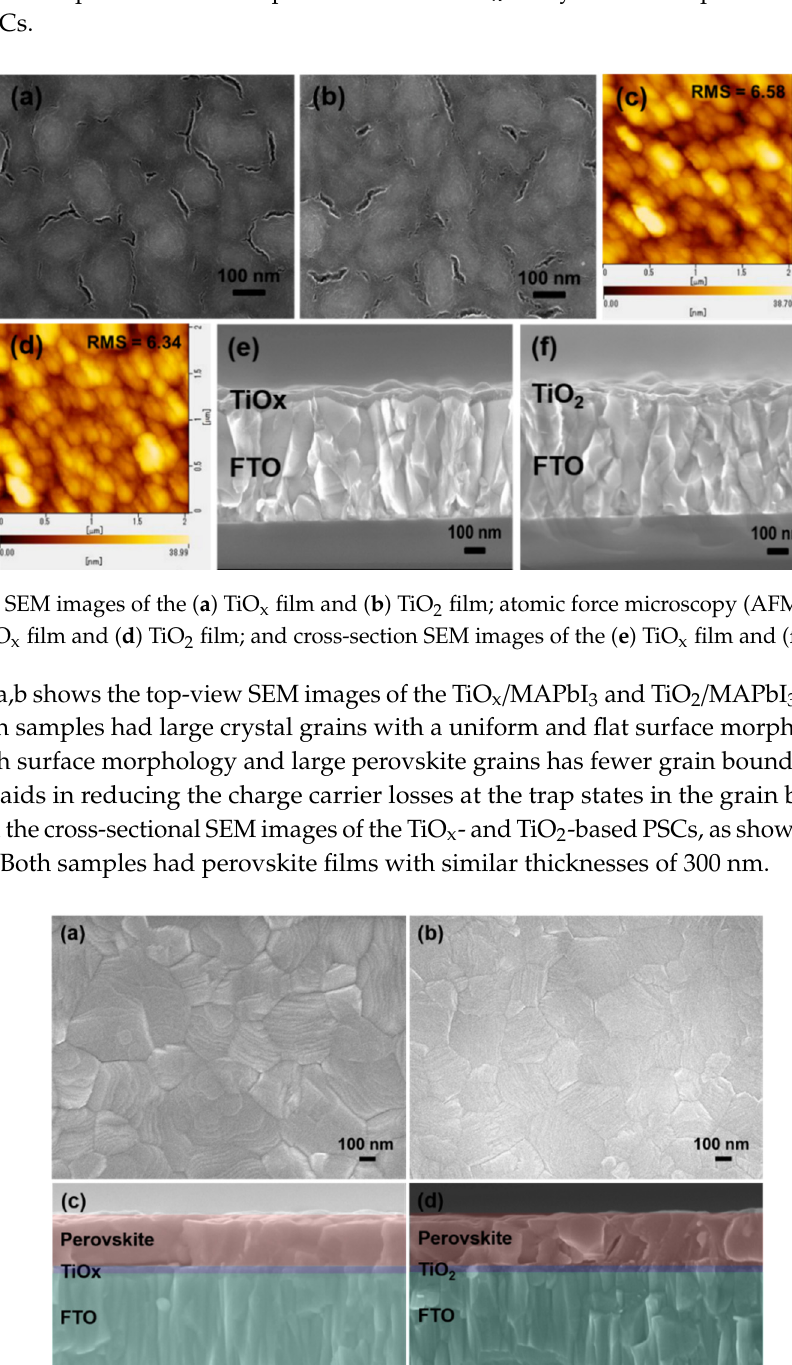
Figure 4. ( a ) XRD pattern of the perovskites formed on the TiO x and TiO 2 films, and ( b ) photoluminescence (PL) spectra of the perovskites formed on the FTO substrate, FTO/TiO x film, and FTO/TiO 2 film. We carried out electrochemical impedance spectroscopy (EIS) to further investigate the electrical properties of each interface, including the charge transfer, carrier recombination, and inner series resistance. Figure 5 shows Nyquist plots of the TiO x - and TiO 2 -based devices at zero bias in the dark and under AM 1.5G–100 mW/cm 2 simulated sunlight irradiation. According to the equivalent circuit model shown in the Figure 5a inset, detailed Nyquist plots fitting the analysis parameters of the corresponding devices are summarized in Table S1. R1 can be considered a resistance component derived from the ETL, while R2 is termed as a resistance component derived from the interface between the ETL and perovskite. R1 is a resistance component derived from the ETL and is labeled as charge transferred resistance (RCT). The reduction in RCT contributed to the superior charge transfer in the TiO 2 -based device compared with the TiO x -based device, implying that a difference in the crystallinity of TiO 2 may contribute to charge transfer at the interface. In addition, R2 is a resistance component at the interface and is considered to be a charge recombination resistance. The larger value contributed to a lower recombination at the interfaces. Mostly equivalent values were obtained for both devices for R2, which is consistent with the results from the corresponding PL spectra (Figure 4b).